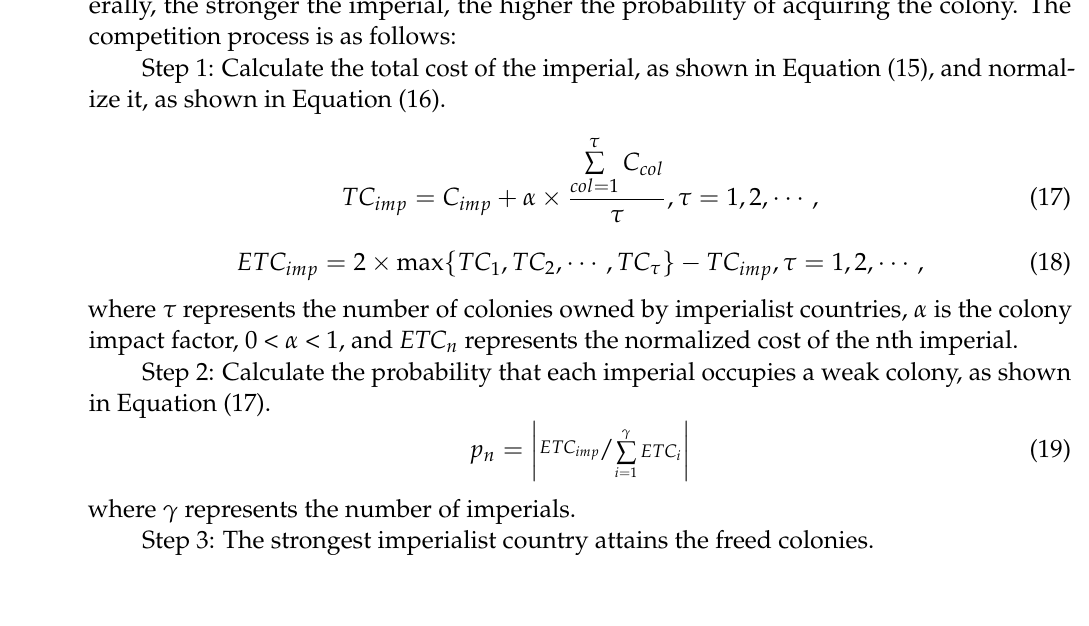
Figure 7. Schematic diagram of the evolution of the improved imperial competition algorithm. Release the most expensive colony among the weakest imperials and compete.